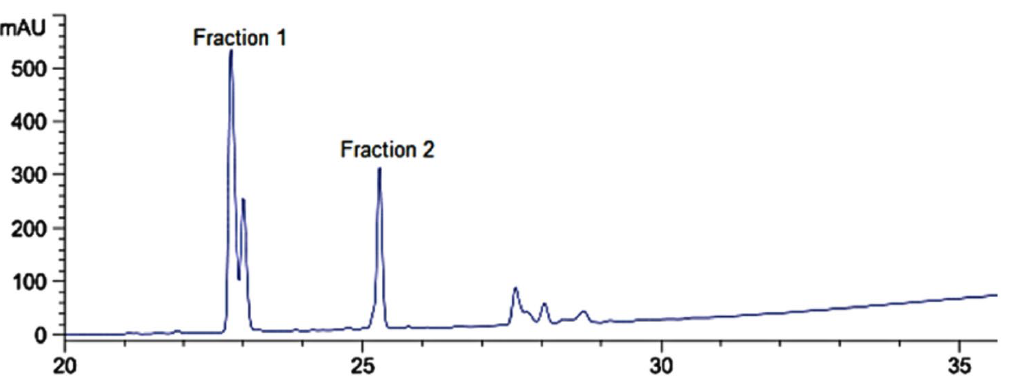
Fig. 3. RP-HPLC chromatogram of lipopetides extract (LPE) from B. amyloliquefaciens MTCC